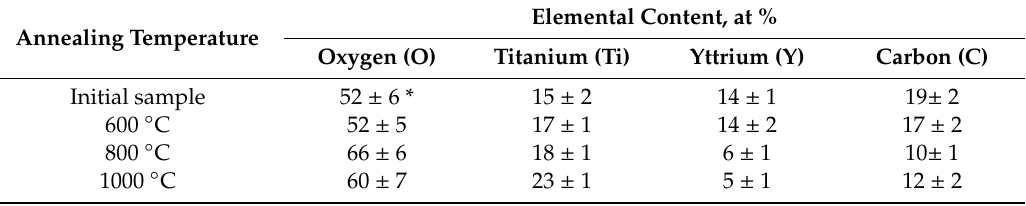
Table 1. Elemental analysis of nanostructures Y 2 O 3 / TiO 2 -Y 2 TiO 5 doped CNTs.